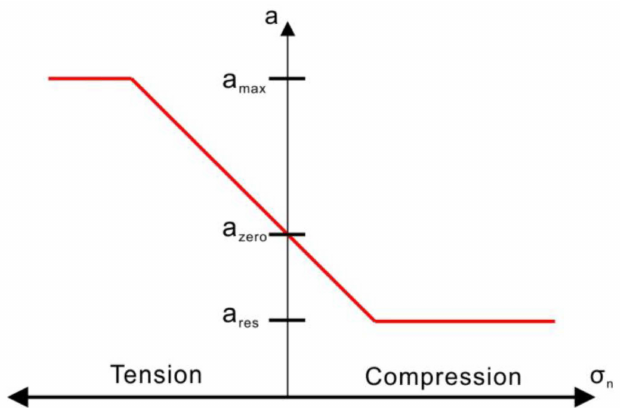
Figure 1. The relationship between fracture aperture and normal